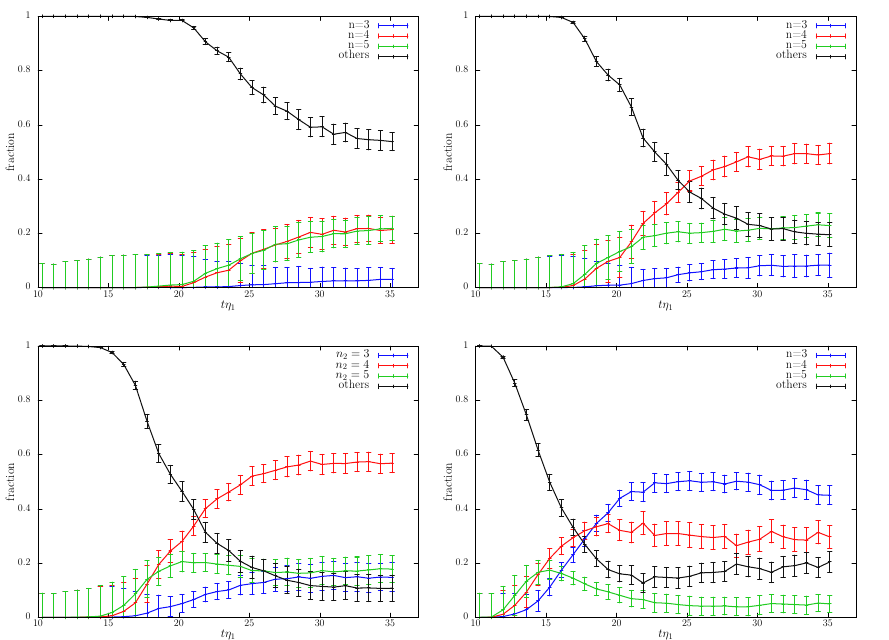
Figure 16 . The time-evolution of R 3 ; 4 ; 5 and R others for various choices of s . The top-left, top- right, bottom-left, and bottom-right (cid:12)gures show the cases with s = 16 (cid:17) (cid:0) 1